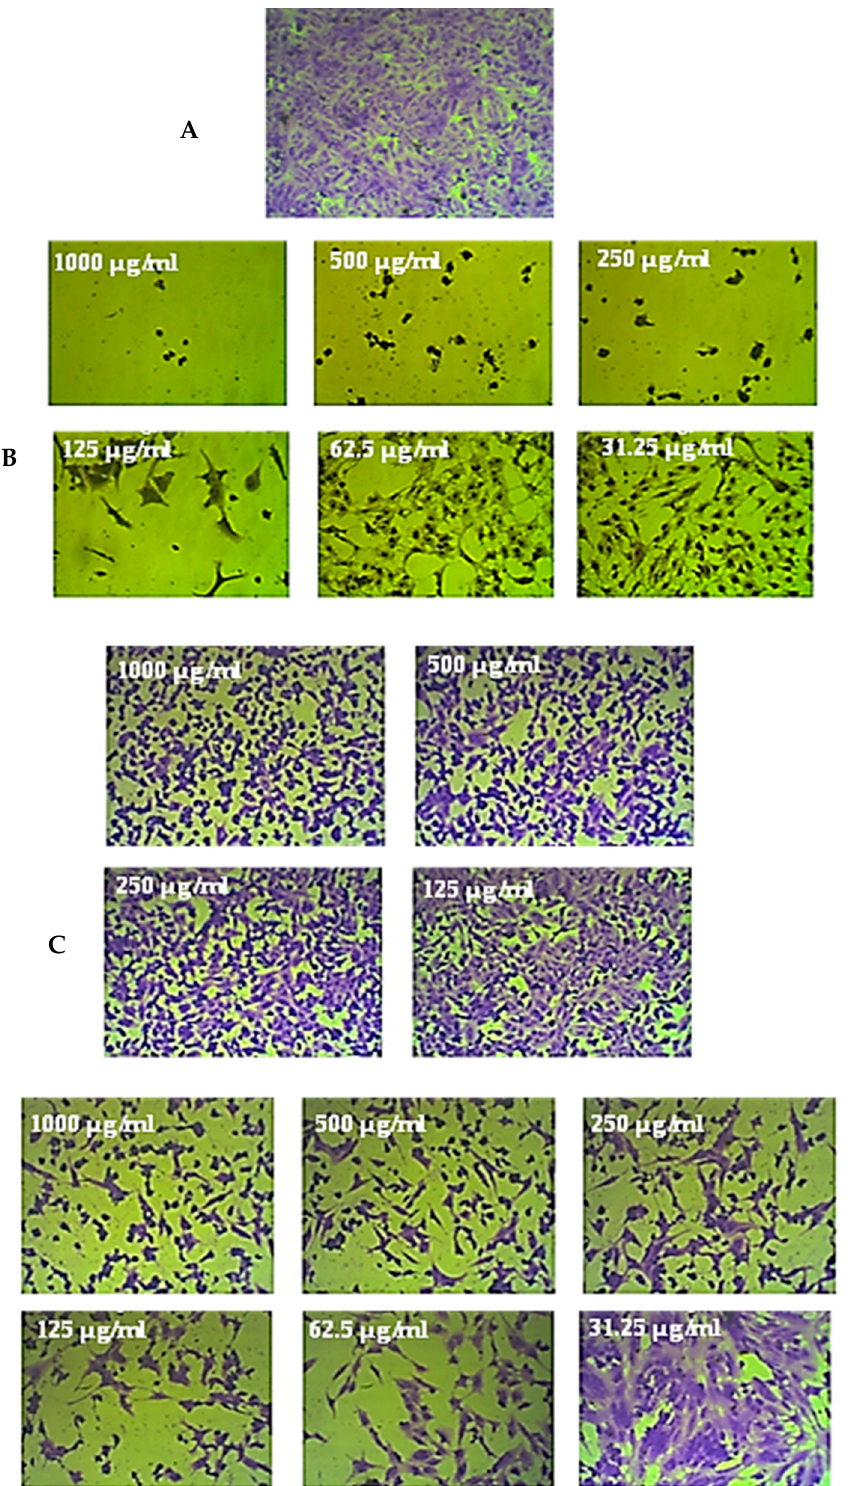
Figure 6. An example of the weak anticancer effects of the leaf extract of R. micronata against prostate cancer cell lines (PC-3). ( A ) Complete monolayer sheets of prostate cancer cell lines (PC-3) that have not been treated. ( B ) The effect of doxorubicin treatment at different concentrations. ( C ) The effect of the leaf extract of R. micronata against PC-3 cell lines at different concentrations. ( D ) The effect of the leaf extract of R. micronata against normal human fetal lung fibroblasts (WI-38) at different concentrations.